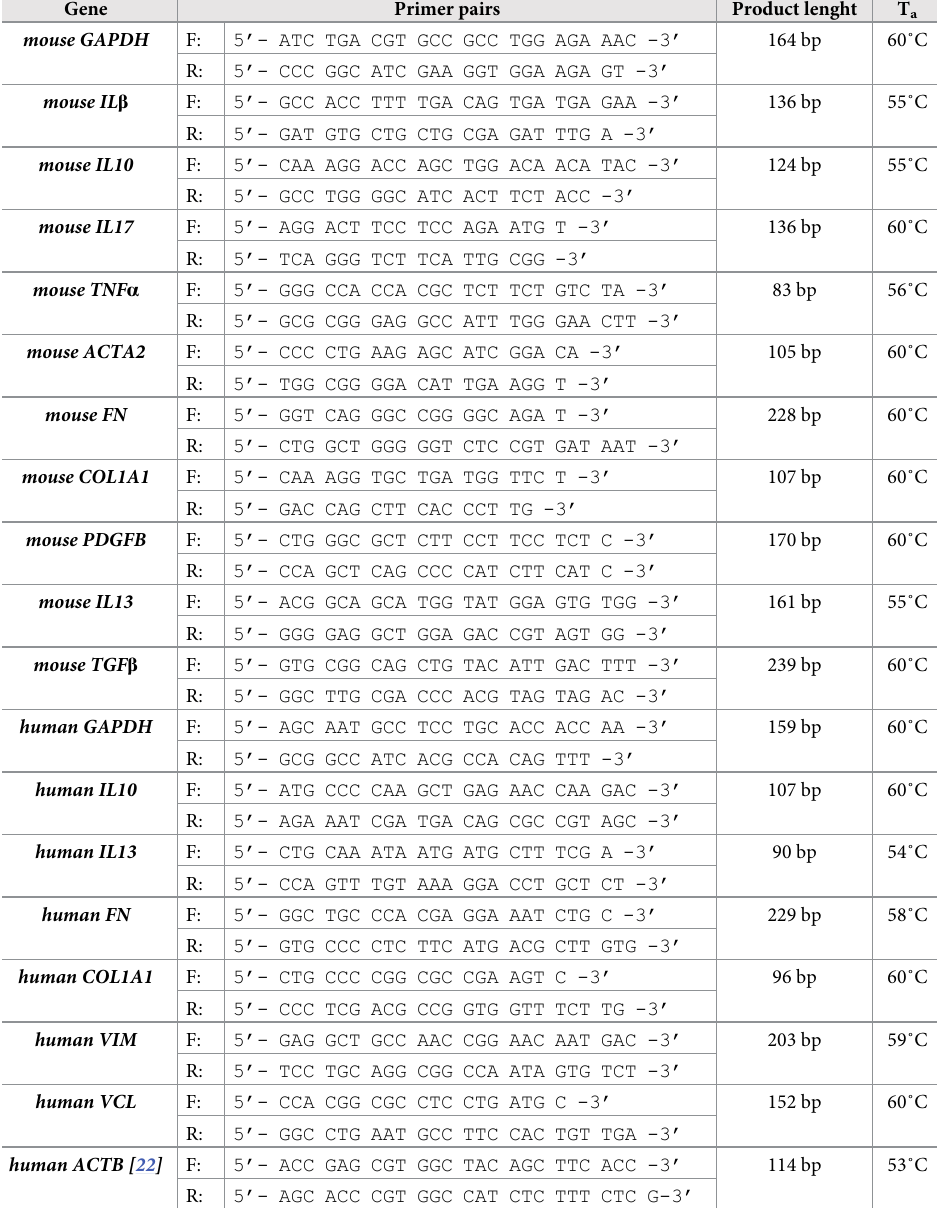
https://doi.org/10.1371/journal.pone.0258502.t001 Protein isolation and Western blot analysis Dermal tissue samples from mice were homogenized in lysing solution, containing 50 mM HEPES, 150 mM NaCl, 1% Triton X-100, 5 mM EDTA, 5 mM EGTA, 20 mM sodium pyro- phosphate, 20 mM NaF, 0.2 mg/mL phenylmethylsulfonyl fluoride, 0.01 mg/mL leupeptin, and 0.01 mg/mL aprotinin (pH 7.4) (each substance obtained from Merck). Thereafter protein concentration was determined by a detergent-compatible protein assay (BioRad, Hercules, CA, USA). Denatured samples (20 μ g protein/lane) were loaded and separated on 4–20%